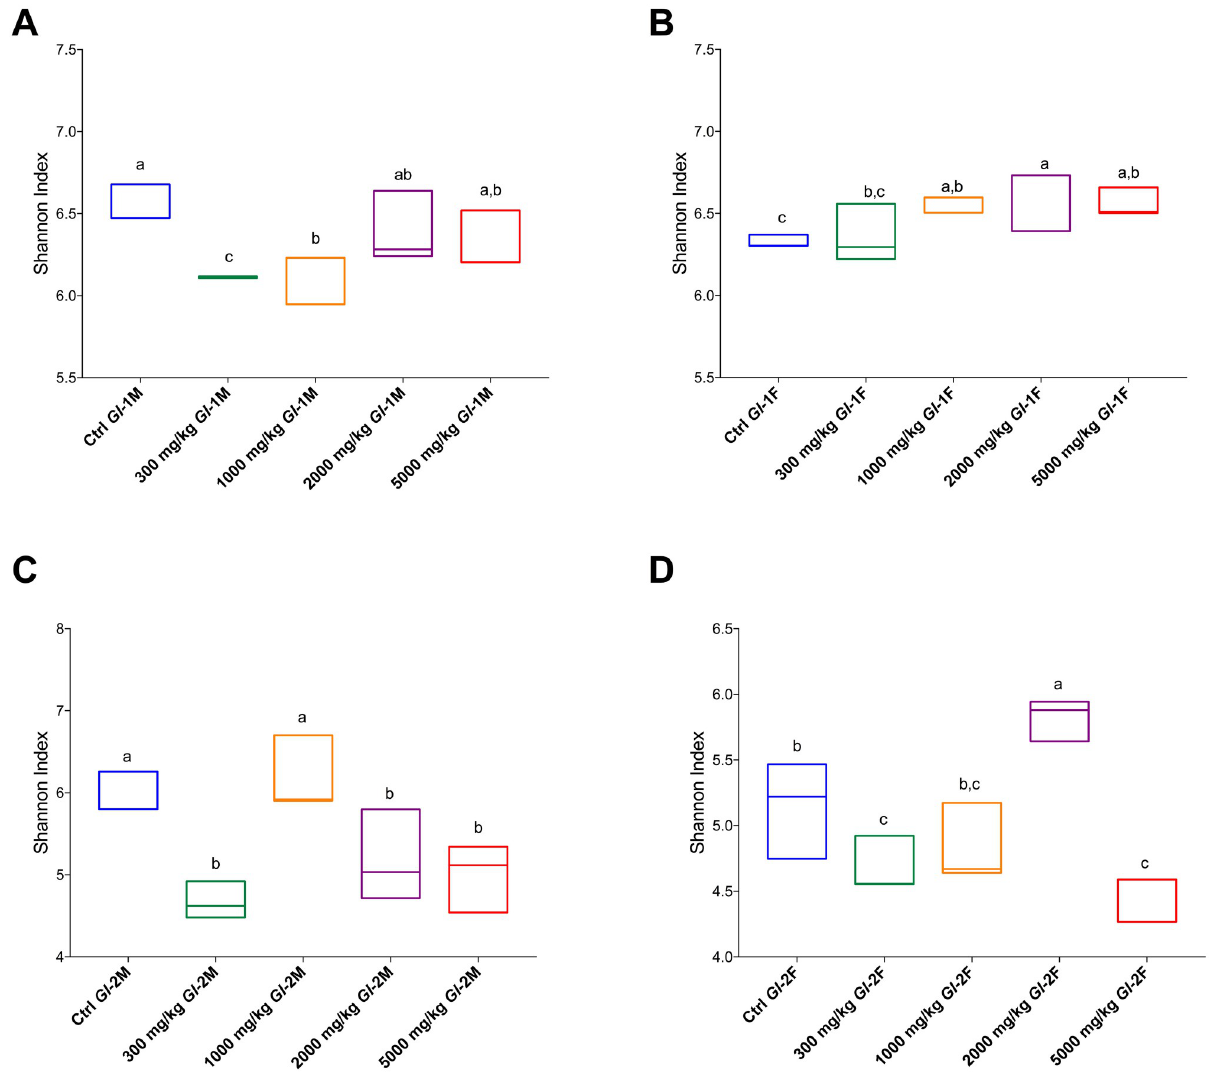
Fig 13. Comparative alpha diversity in the gut microbiota from the male (M) or female (F) Wistar rats fed with the control diet (Ctrl) and different doses of standardized Gl -1 or Gl -2 extracts of Ganoderma lucidum for 14 experimental days, according to the Shannon index. A–B: Administration of the Gl -1 extract. C–D: Administration of the Gl -2 extract. The dose administered per experimental group is described in the materials and methods section. Different letters on a box indicate significant differences, p < 0.05. Values ( p ) correspond to one-way ANOVA from Tukey’s multiple comparison